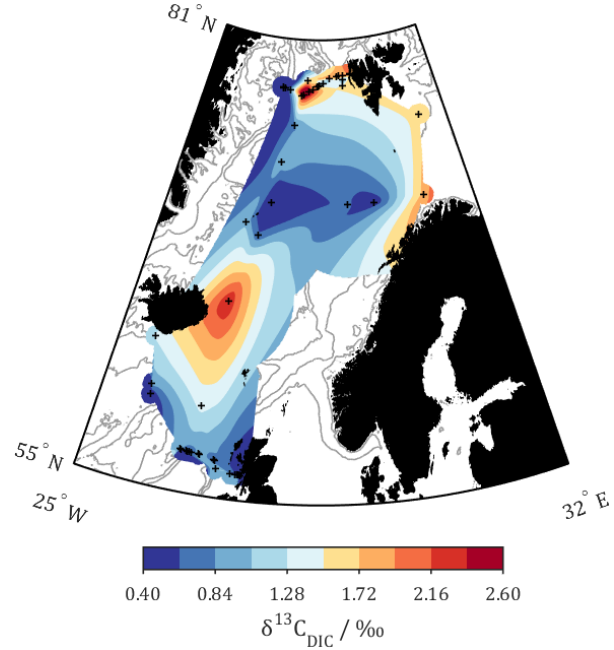
Figure 6. Measured δ 13 C DIC /‰ for all samples from both cruises collected at a depth shallower than 10m. Actual sampling points are indicated by black plusses.